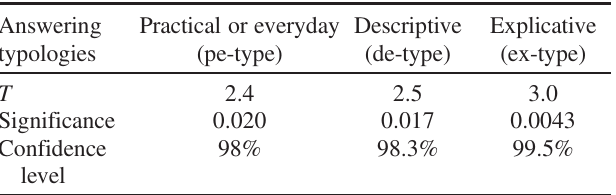
TABLE III. Student ’ s T -statistic results for the comparison between the research sample and control group.